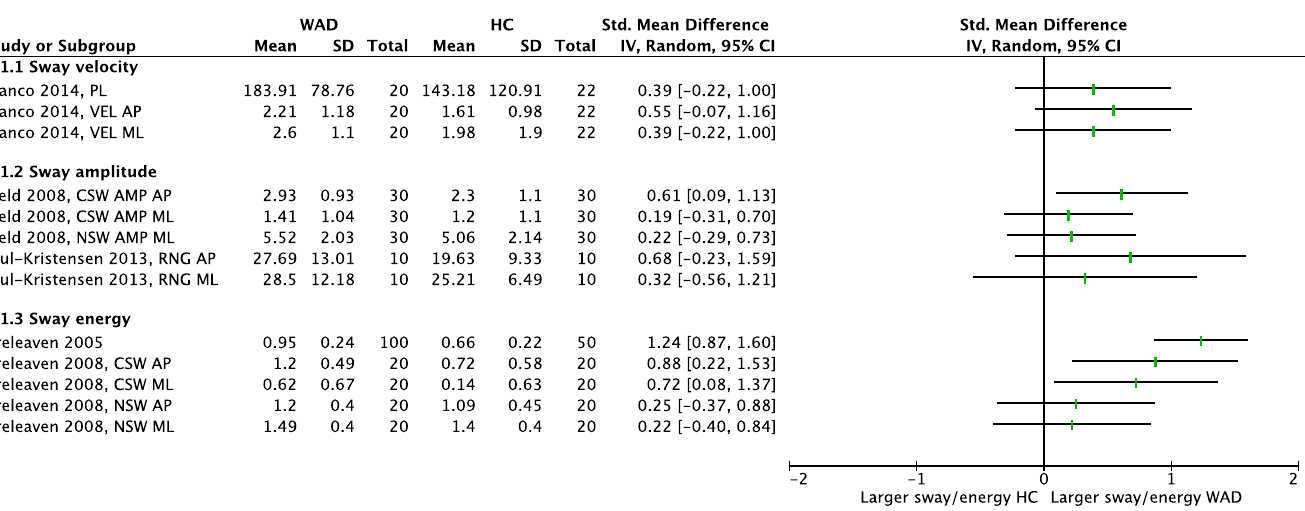
Fig 6. Forest plot, without meta-analysis, demonstrating sway velocity, sway amplitude and sway energy (eyes open) in people with WAD vs. HC. WAD: whiplash- associated disorder; HC: healthy control; SD: standard deviation; IV: inverse variance; CI: confidence interval; Std: standardized; VEL: velocity (mm/s); PL: path length (mm); AMP: amplitude (mm); RNG: range (mm); AP: anteroposterior; ML: mediolateral; CSW: comfortable stance width; NSW: narrow stance width.